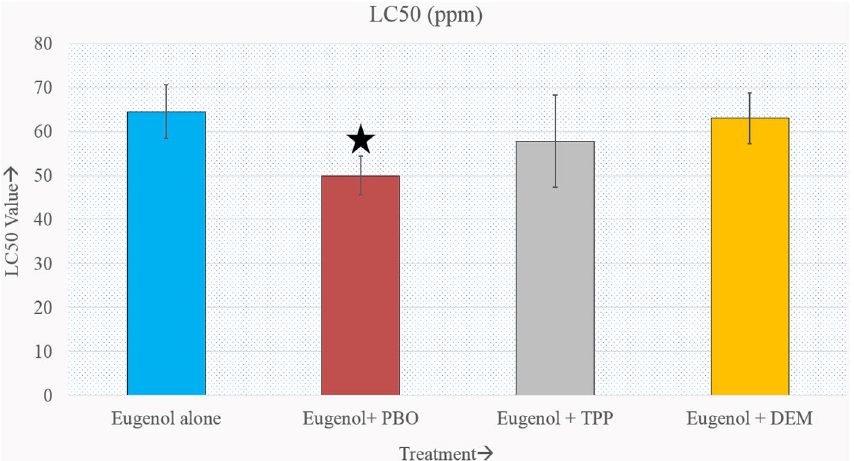
Figure 6. Effect of synergists + eugenol on the median lethal concentration (LC50) on the F30 larvae of A. aegypti . As the 95CIs overlap between all three synergized eugenols, we have compared eugenol + PBO and Eugenol alone. 95% confidence intervals for each LC50 are presented in the form of error bars for each synergized